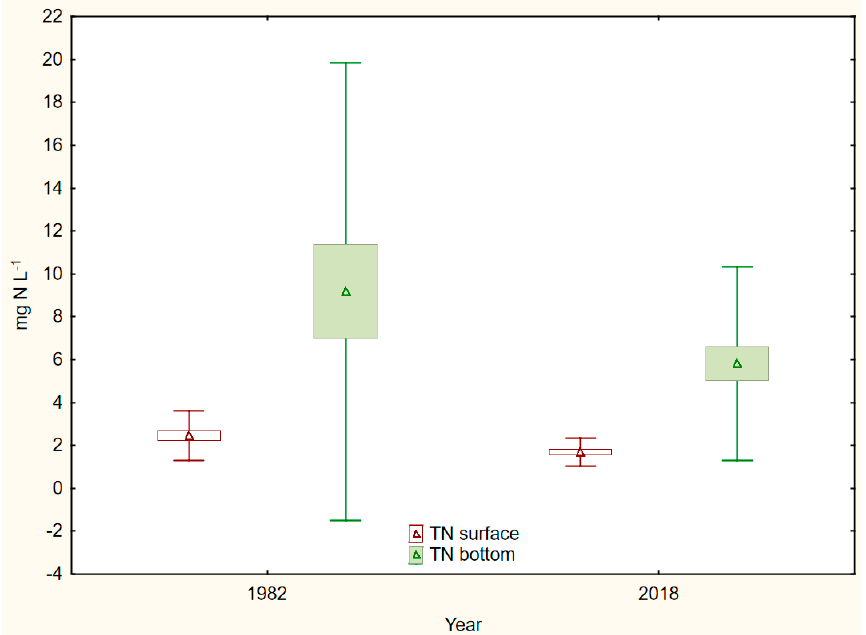
Figure 7. Mean annual (1982 and 2018) values of the total nitrogen content (±SD) in the water of Mi ł kowskie Lake.